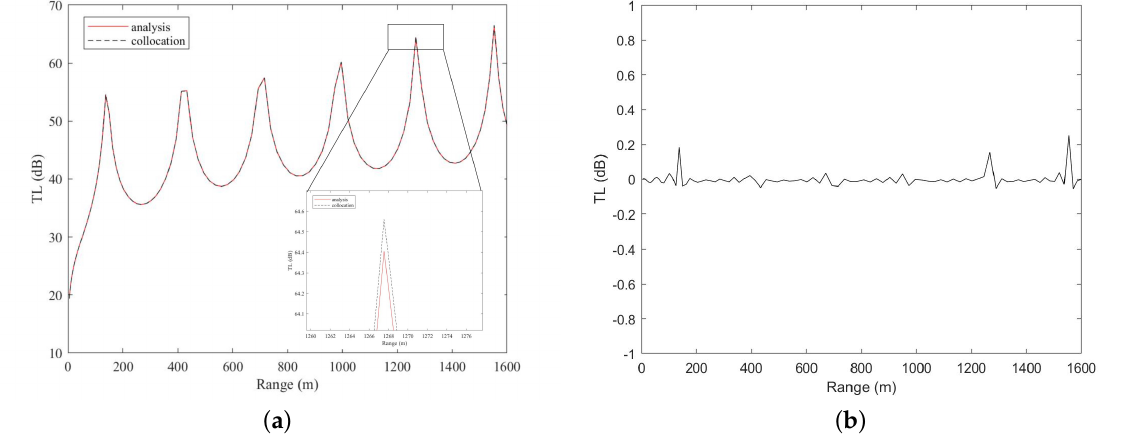
Figure 5. The TL curve calculated by the analytical solution (red solid line) and the Chebyshev–collocation method (black dashed line) at the sound source depth ( a ); the error between the numerical solution and the analytical solution ( b